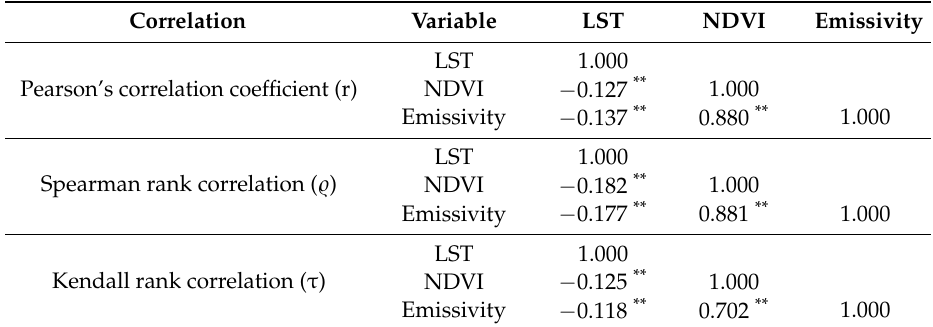
Table 2. Parametric (Pearson’s r) and non-parametric (Spearman’s (cid:36) and Kendall’s τ ) correlation for Landsat derived variables in L1 transect. Number of samples = 4572.